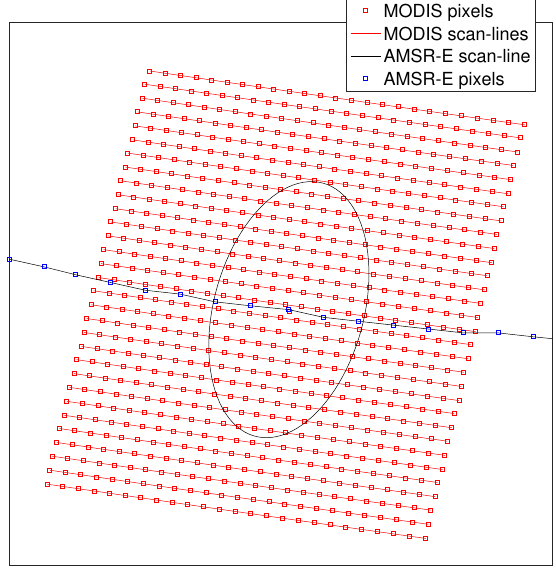
Figure 2. Example of matchup